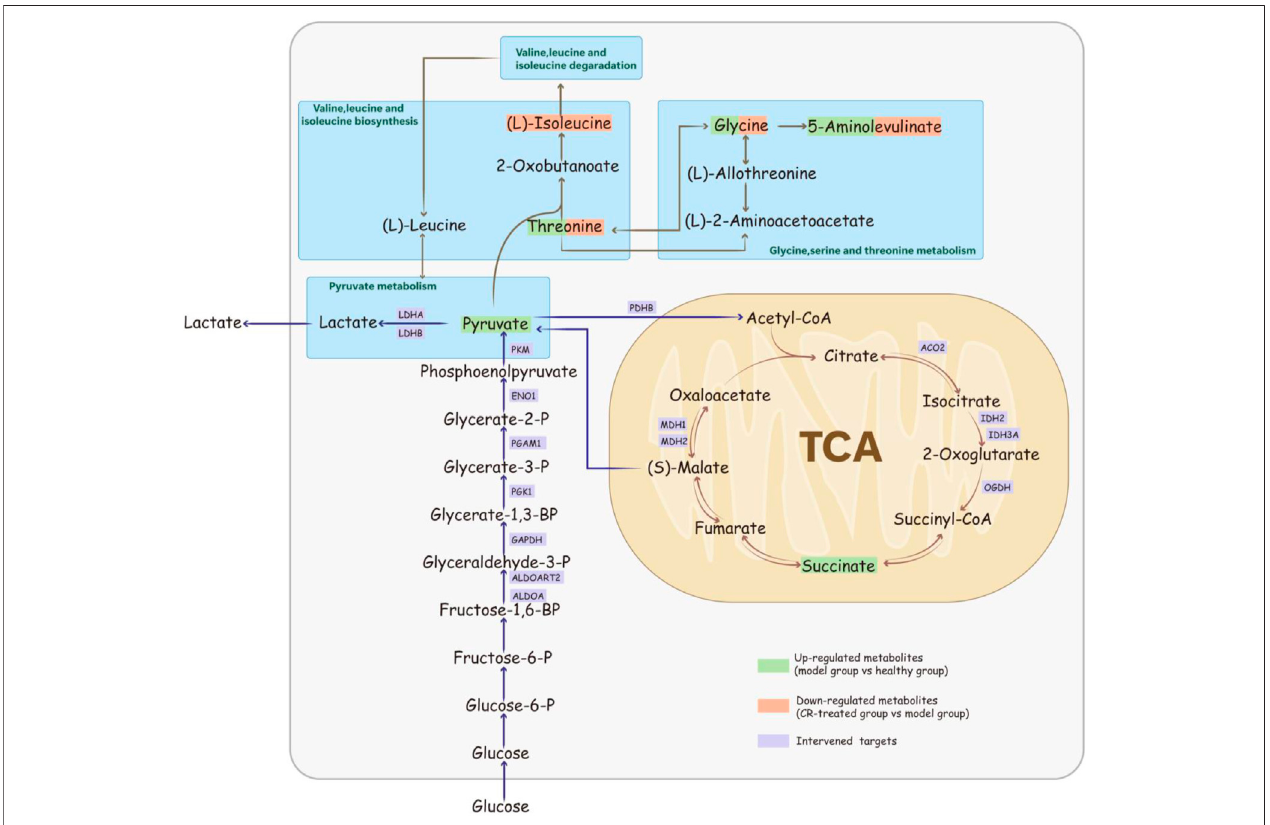
FIGURE 5 | Schematic diagram of Codonopsis pilosula (Franch.) Nannf. ‘ s mechanism for suppressing GPL via the energy-related